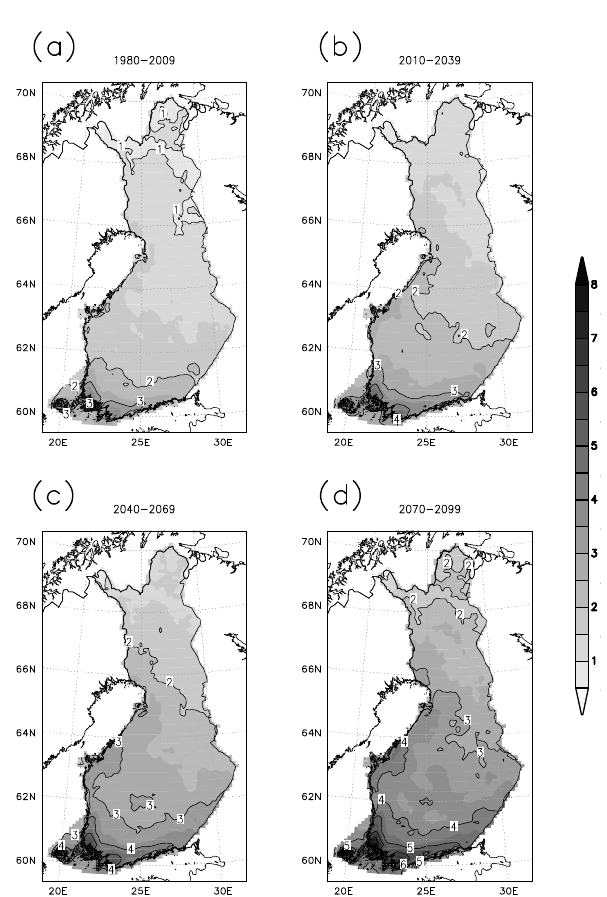
Figure 9. Projected multi-model mean for the April–October